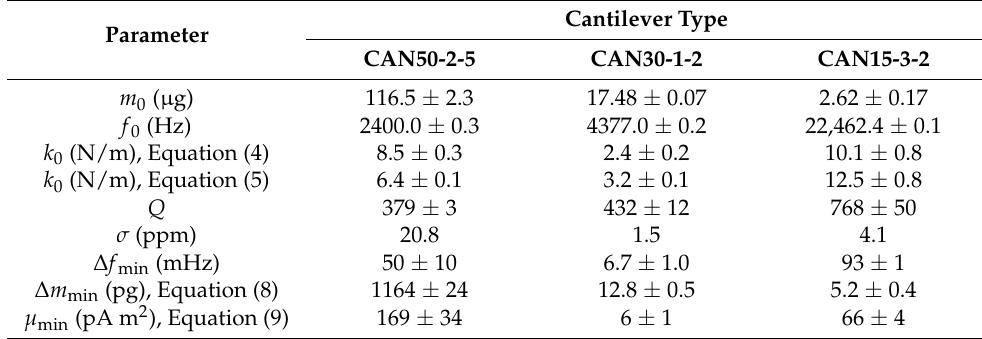
Table 2. Resonant MEMS cantilever sensor